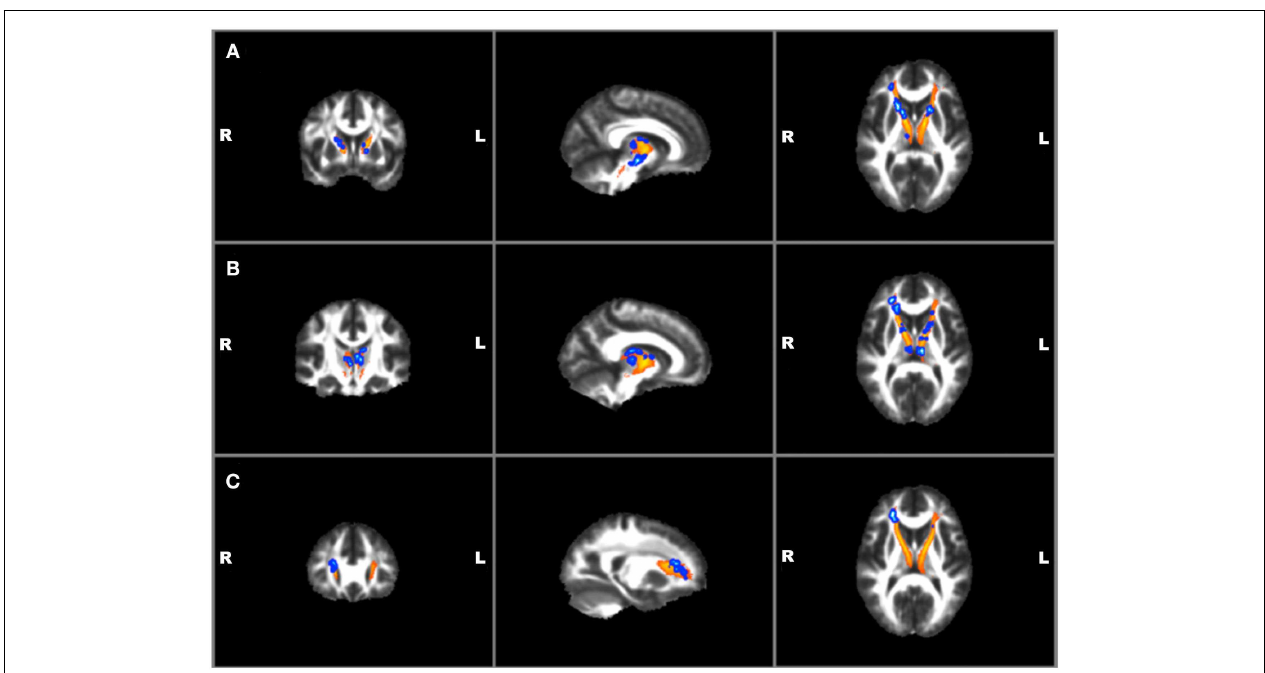
FIGURE 4 |Voxel-wise anterior thalamic regressions inTBI + SB group showing significant ( p ≤ 0.01) * positive regressions in blue superimposed on the yellow-orange total thalamic radiations mask for